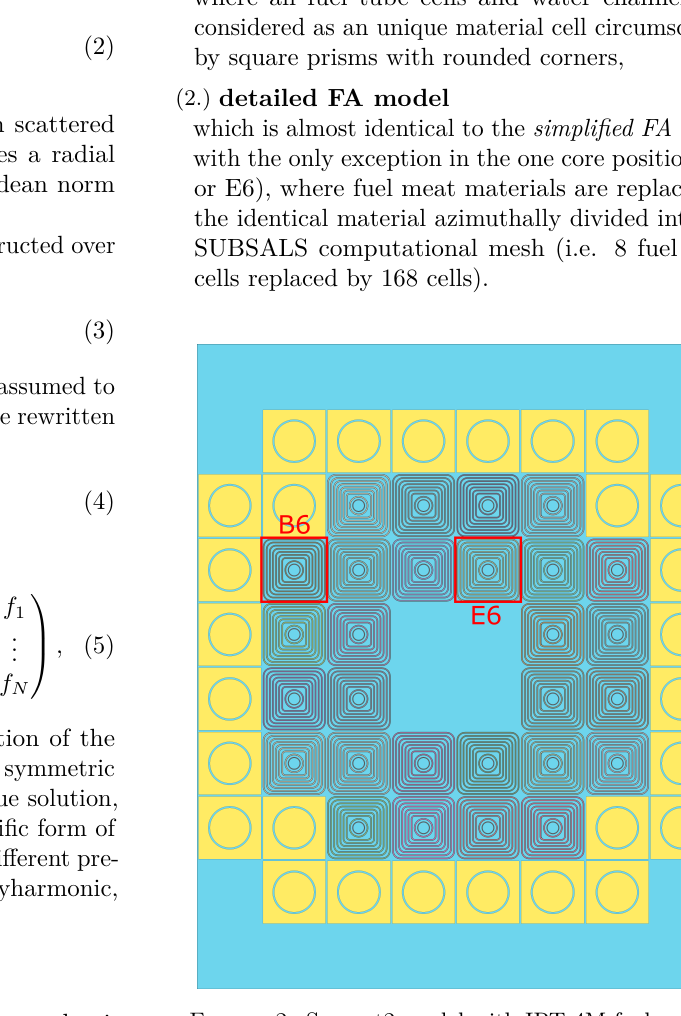
Figure 2. Serpent2 model with IRT-4M fuel assem- blies surrounded by beryllium blocks (framed positions B6 and E6 of particular